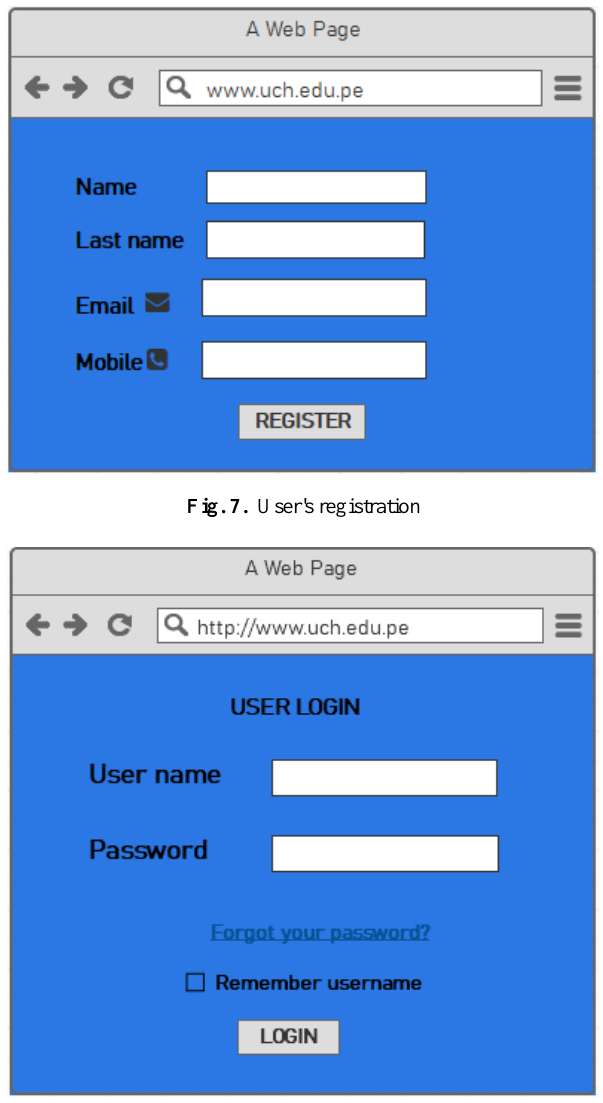
Fig. 8. Page dedicated to the user’s